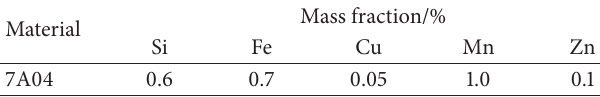
Table 1: Chemical composition (%) of 7A04 aluminum alloy. Material